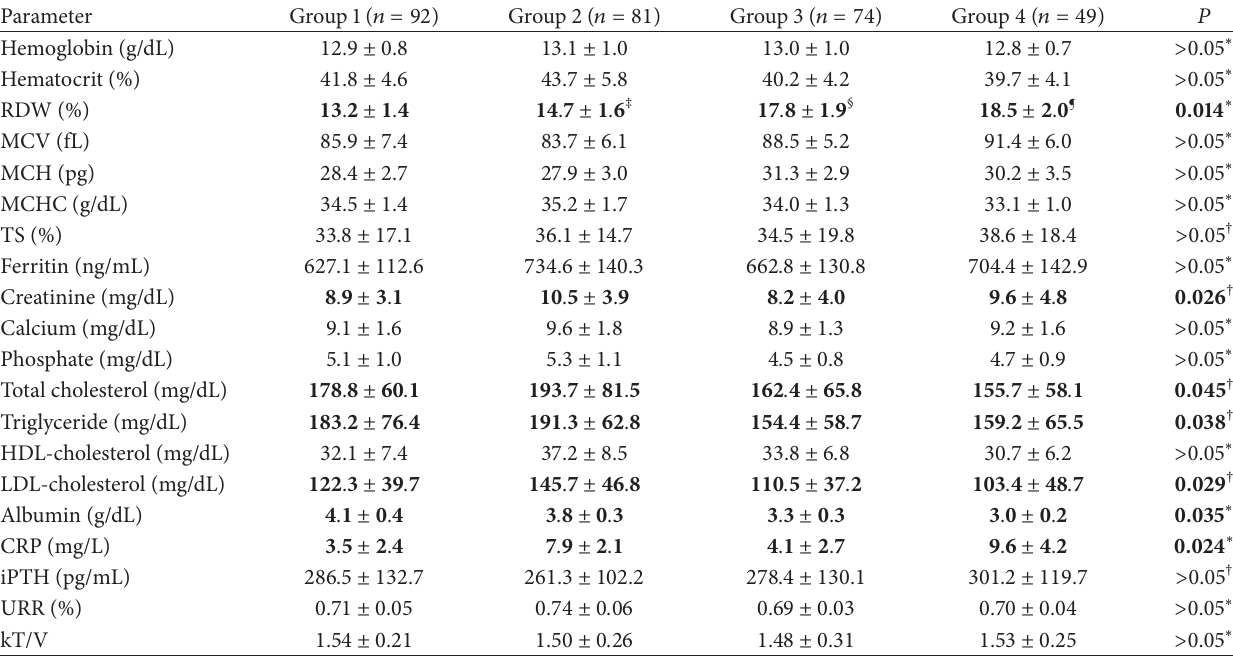
Table 2: The comparative clinical and laboratory data of HD patients.